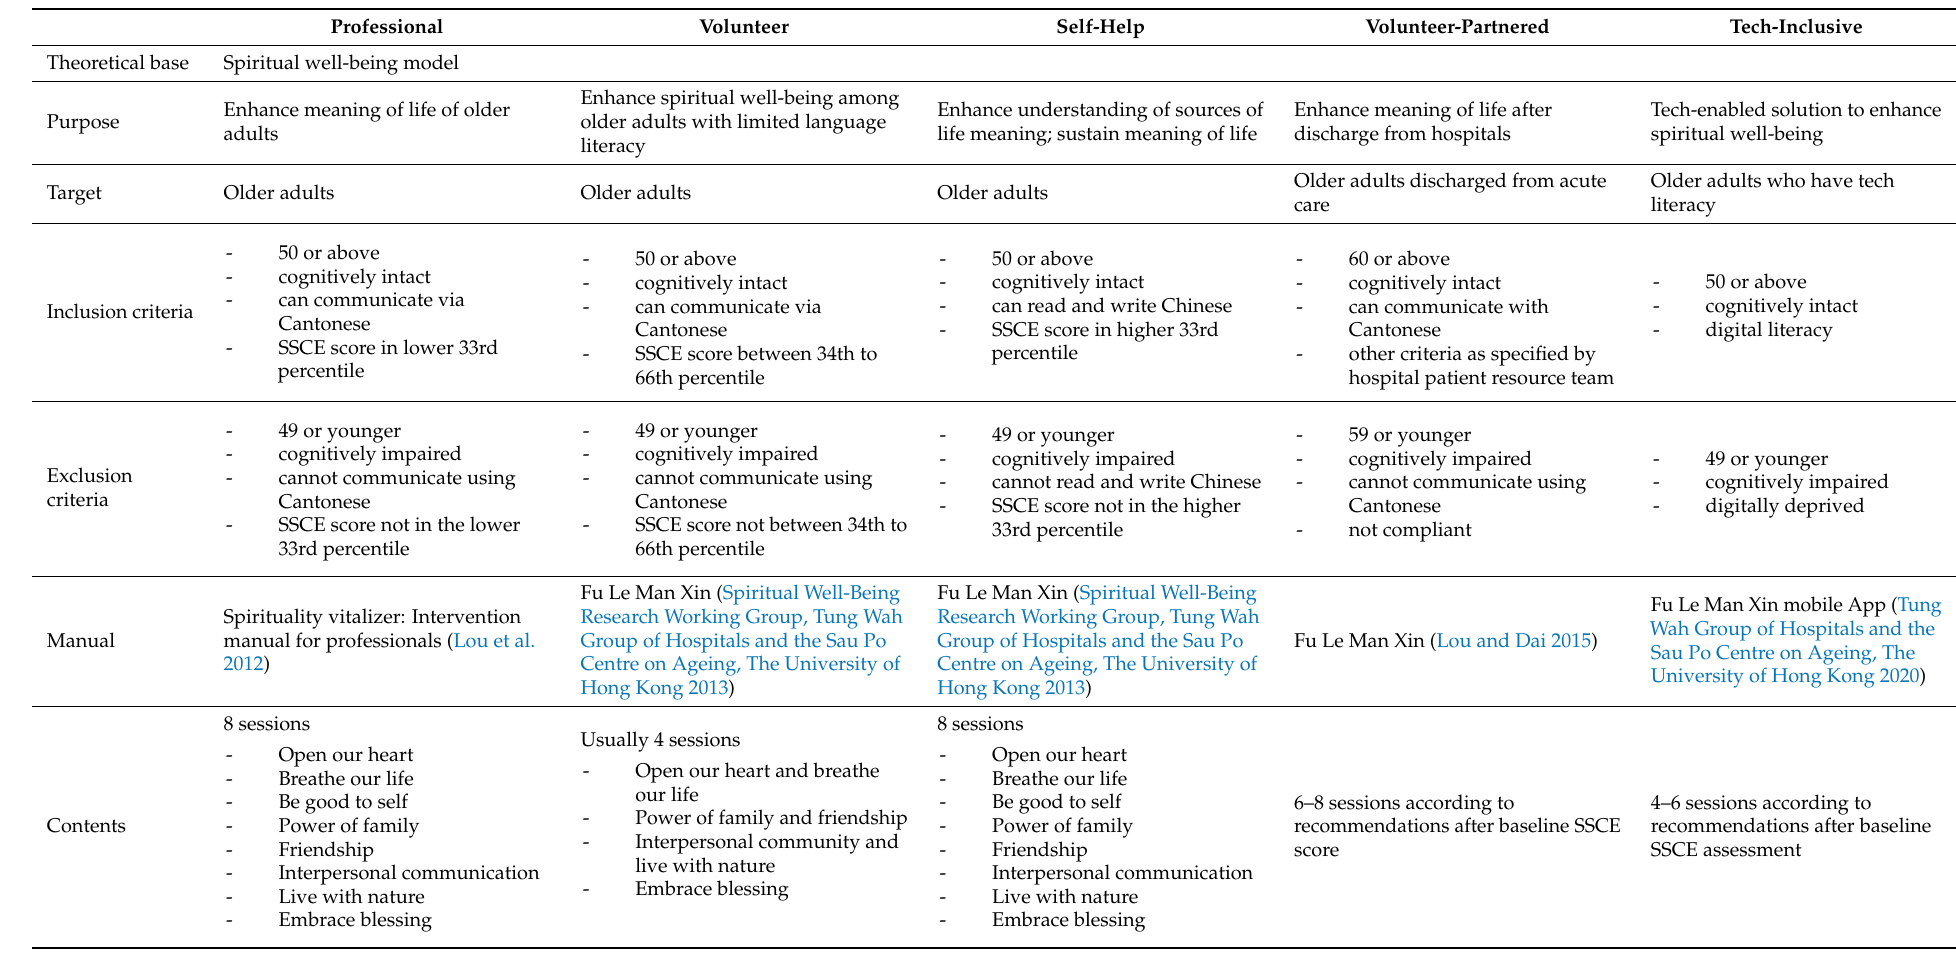
Table A1. A Summary of Evidence-Based